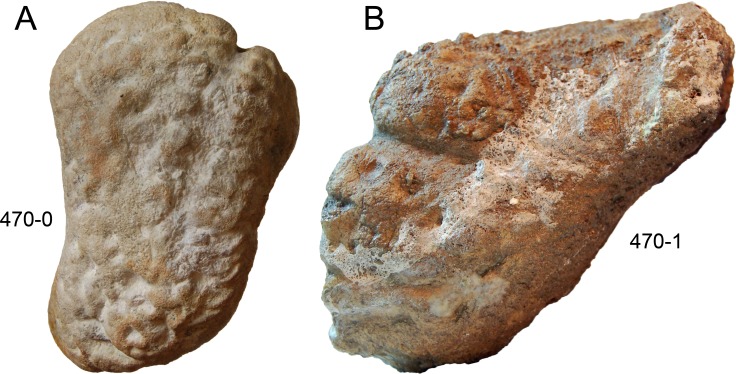
Eusauropod metatarsals IV.Right (A) and left (B) metatarsal IV of Suuwassea emilieae ANS 21122 (A) and Cetiosauriscus stewarti NHMUK R3078 (B) in proximal view, illustrating the curved (A; C470-0) and subtriangular outlines (B; C470-1). Scaled to the same dorsoventral height.